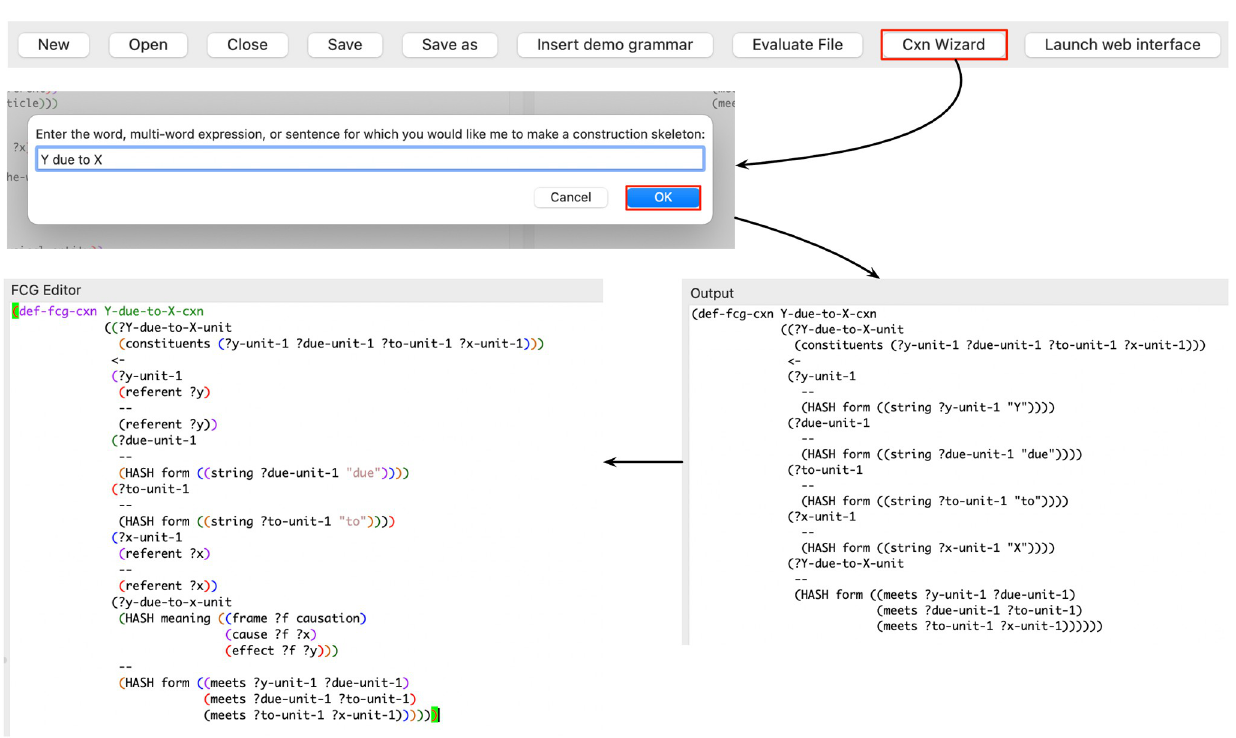
Fig 4. Construction wizard. After clicking the ‘Cxn Wizard’ button from the toolbar, a window opens in which the user can type a word, multi-word expression or sentence for which they wish to create a construction skeleton. Upon clicking ‘OK’, the construction skeleton is printed to the output pane, from where it can be copied to the grammar that is open in the editor pane. The grammar engineer can then further elaborate this construction and test it.